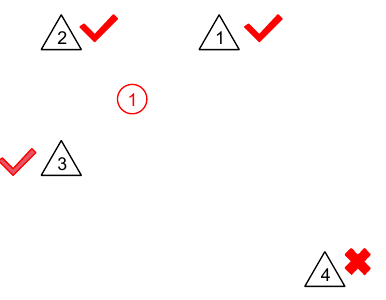
Figure 3. A “jump point” for WiFi fingerprint matching. A multidimensional fingerprint algorithm is proposed here to solve the jump point problem. By increasing the amount of historical fingerprint information and reducing the impact of single fingerprint matching, the fingerprint matching algorithm becomes more stable. In this case, n represents the number of WiFi access points collected simultaneously; the square represents the RSS of the access point; and k denotes the kth time at which the WiFi fingerprint was collected; see Figure 4.